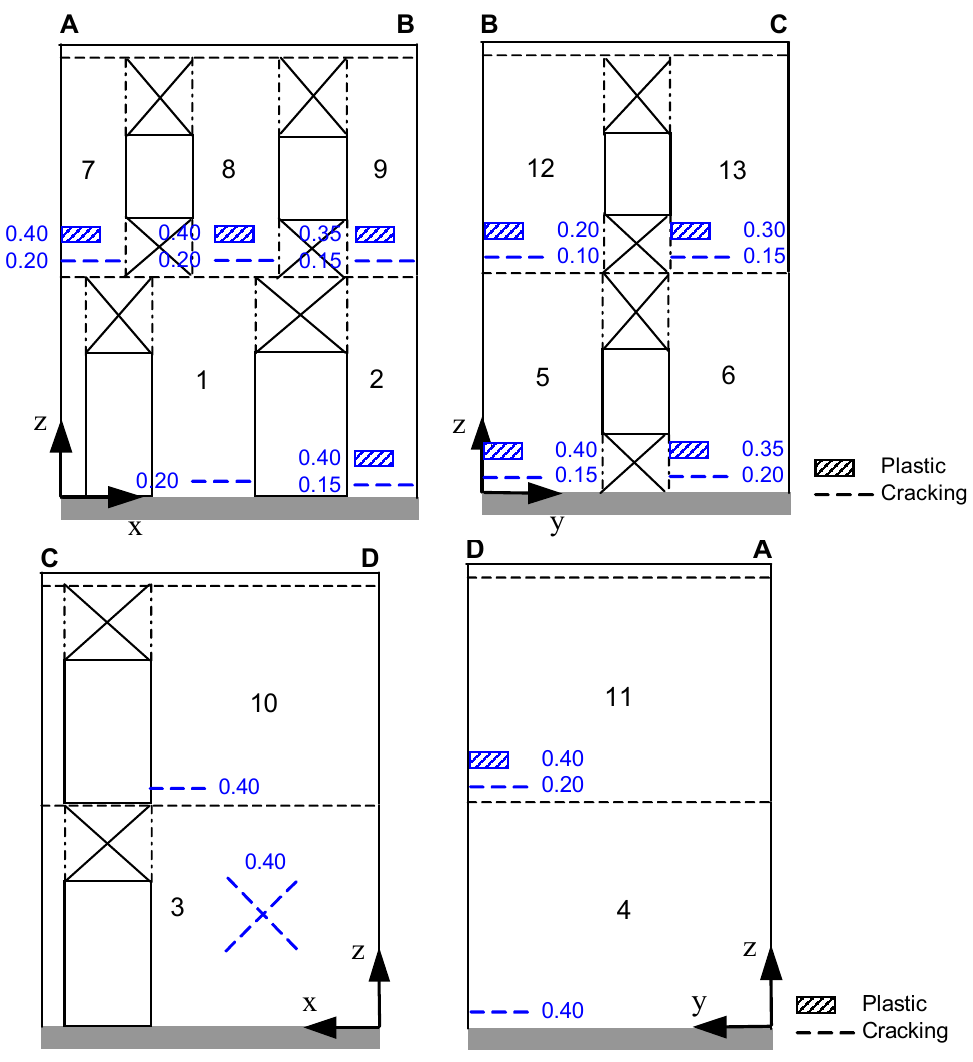
Figure 14. Damage progress obtained by the ME